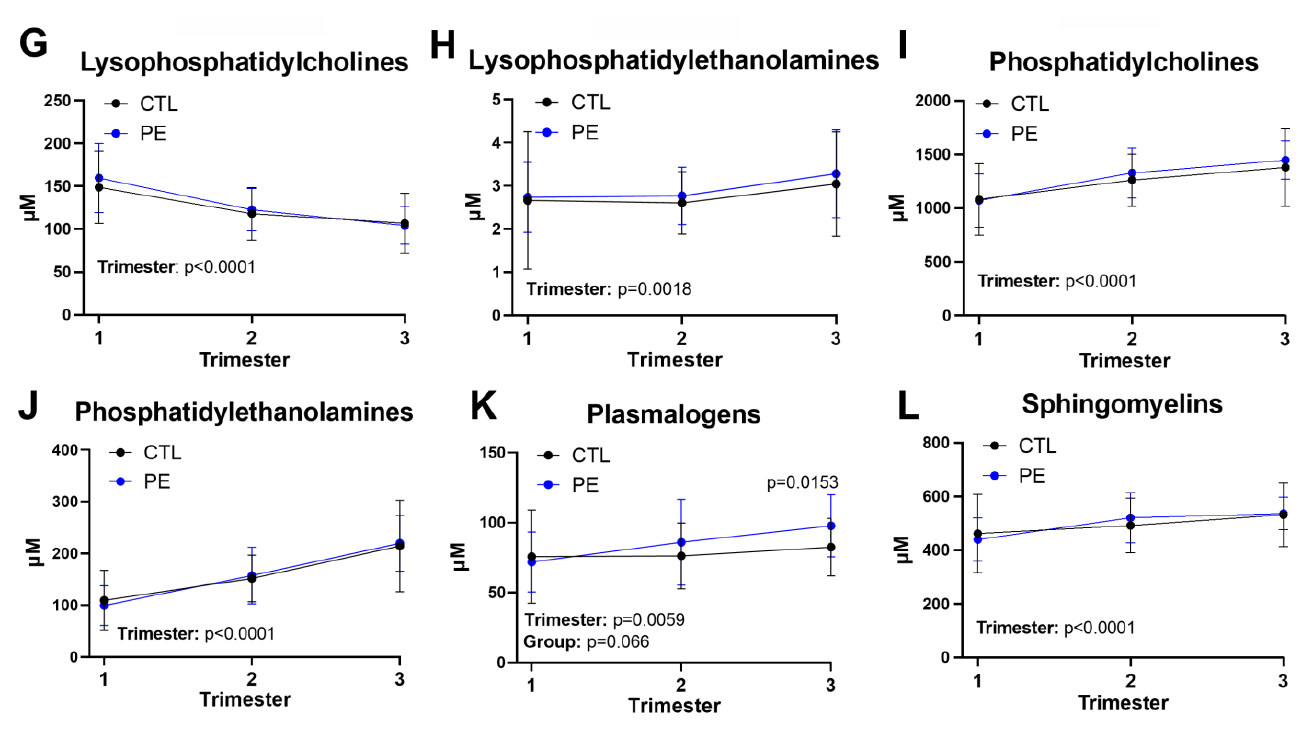
Figure 1. Changes in broad lipid classes during pregnancy. ( A – L ) Plasma concentrations of broad lipid classes at each trimester in uncomplicated (CTL) and preeclampsia (PE) pregnancies. Lipid class concentrations were calculated by summing the concentrations of all individual lipid species, measured by mass spectrometry, within a class. Significant sources of variation were determined by linear mixed effects modeling and are indicated in the lower left of each panel. Šídák’s multiple comparisons test was used to compare CTL and PE groups at each trimester. Error bars represent SD.